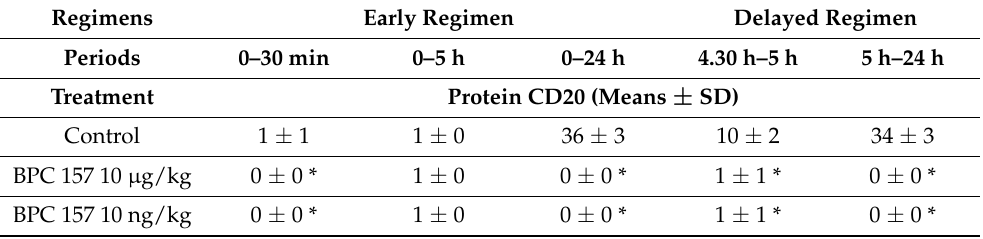
Table 3. Number of CD20-, CD3-, CD68-(PG-M1) and CD163-positive cells in the bile duct-ligated rats following ligation (time 0) at the sequential periods (application sacrifice) to illustrate the effect of both early treatment and delayed treatment following ligation. * p ˂ 0.05, at least, vs. control.